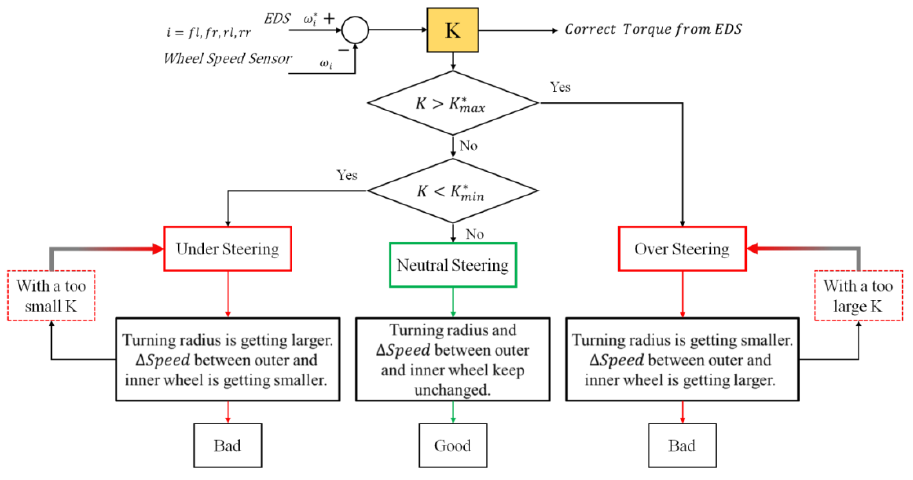
Figure 5. Philsophy of K gain adjusting.